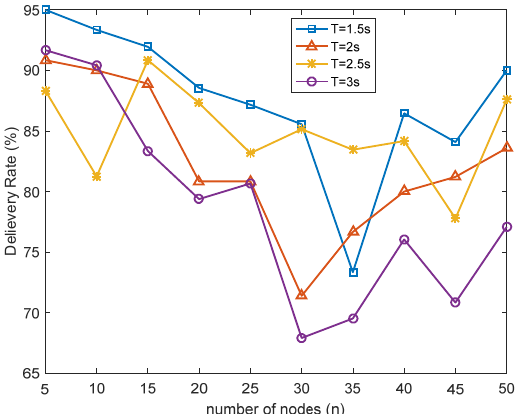
Figure 9. Comparison of pulse cycle delivery rate of beacon routing protocol.